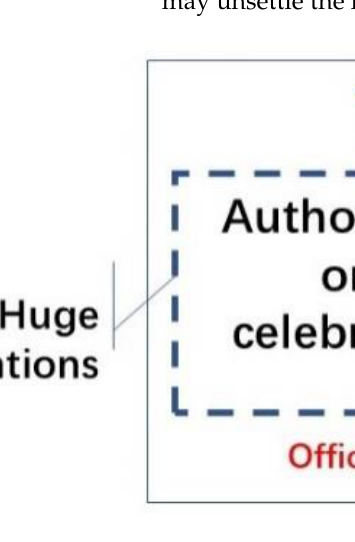
Figure 1. A virtual boundary in the virtual world.